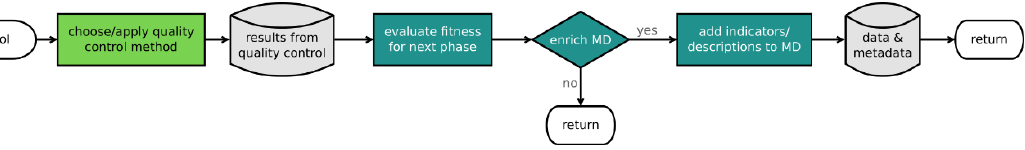
Figure 5. Unfolded predefined process of quality control in the QA workflow (Figure 4).